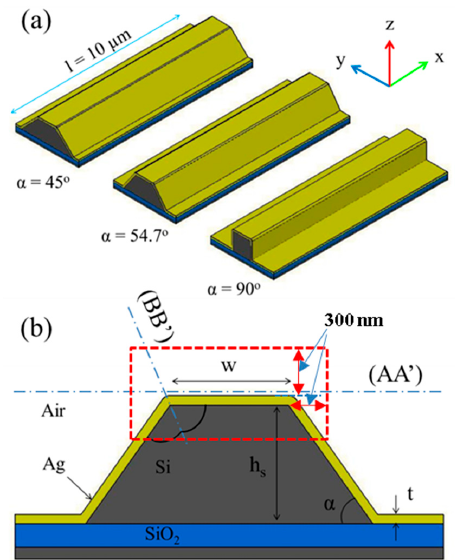
Figure 1. Sketch of ( a ) the proposed wedge SPP waveguides with the sidewall corners α = 45 ◦ , 54.74 ◦ , and 90 ◦ , and ( b ) the cross-section geometry of the wedge SPP waveguide with the trapezoidal cross-section.